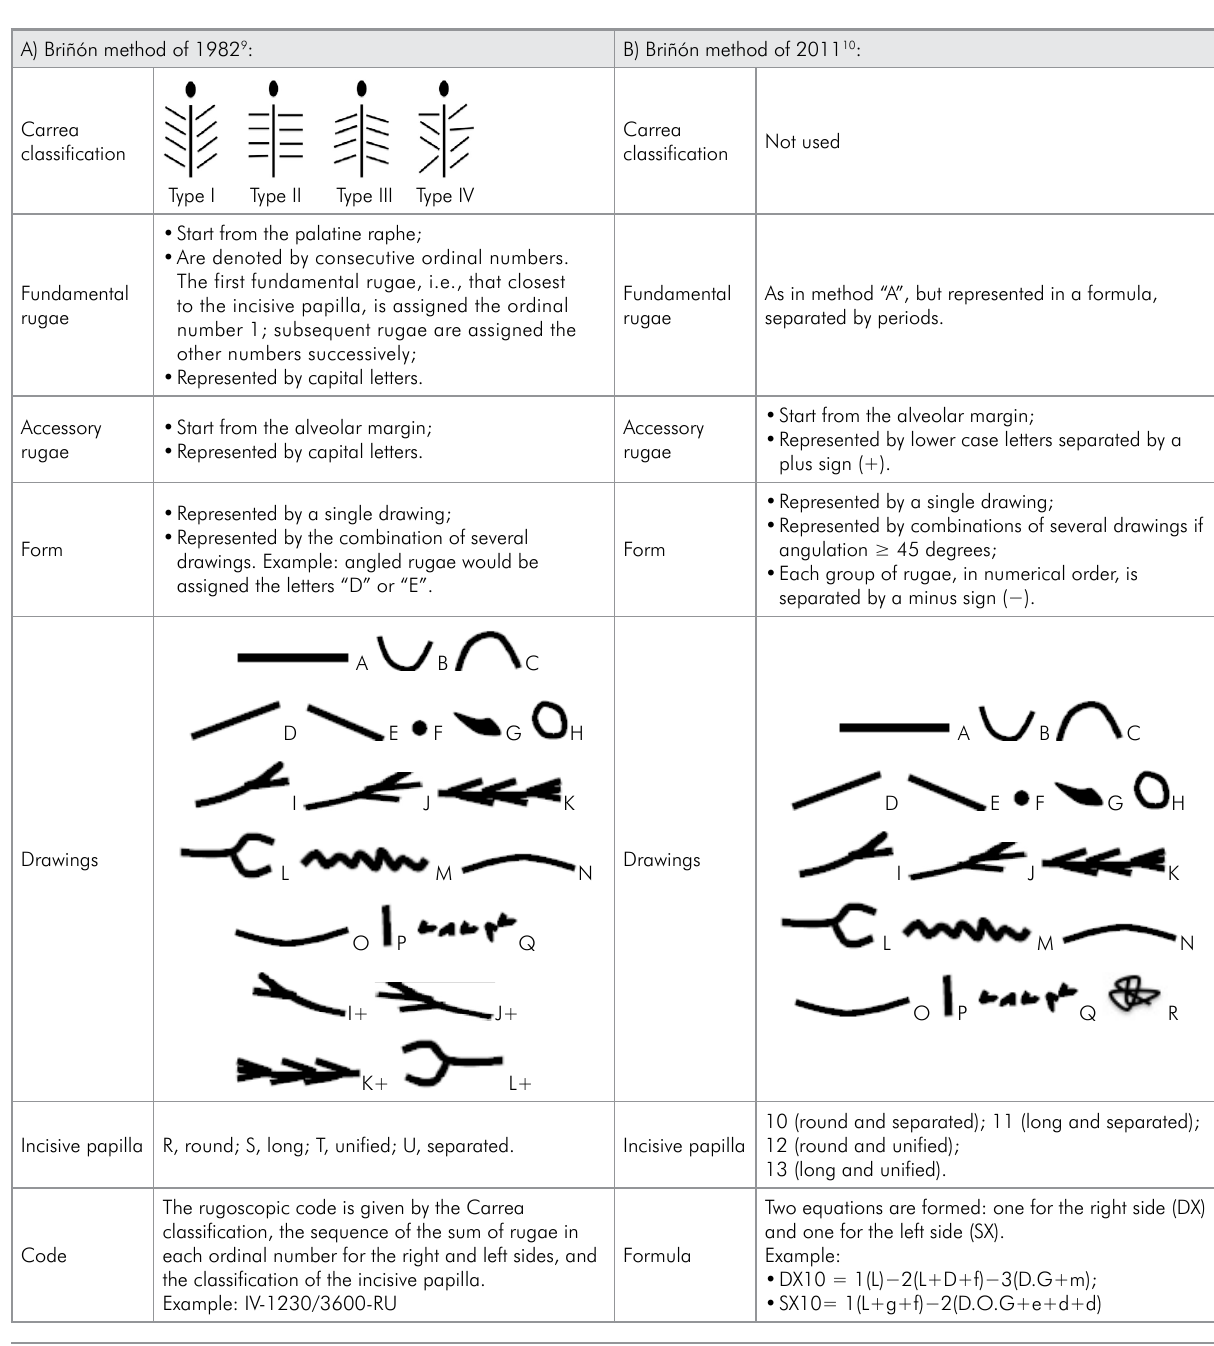
Figure 1. Briñón’s classification of palatal